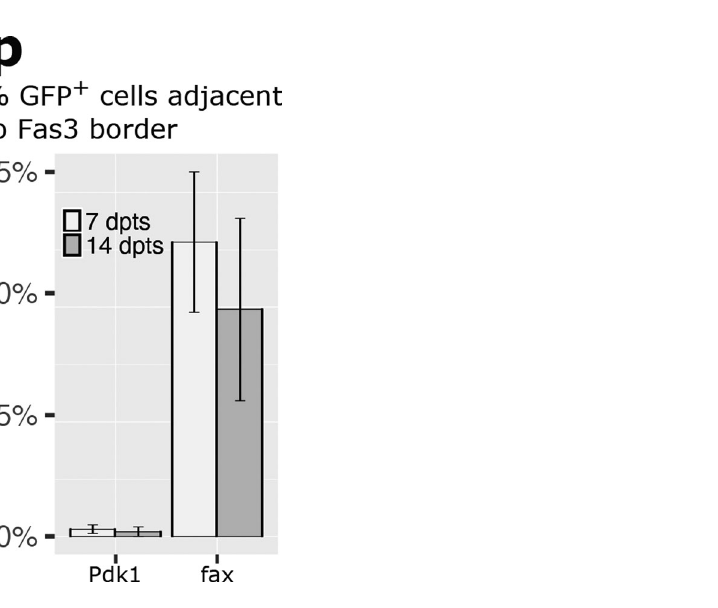
In the original version of Figure 6B, the range of colours used to indicate correlation in gene expression between different cell types were inadvertently